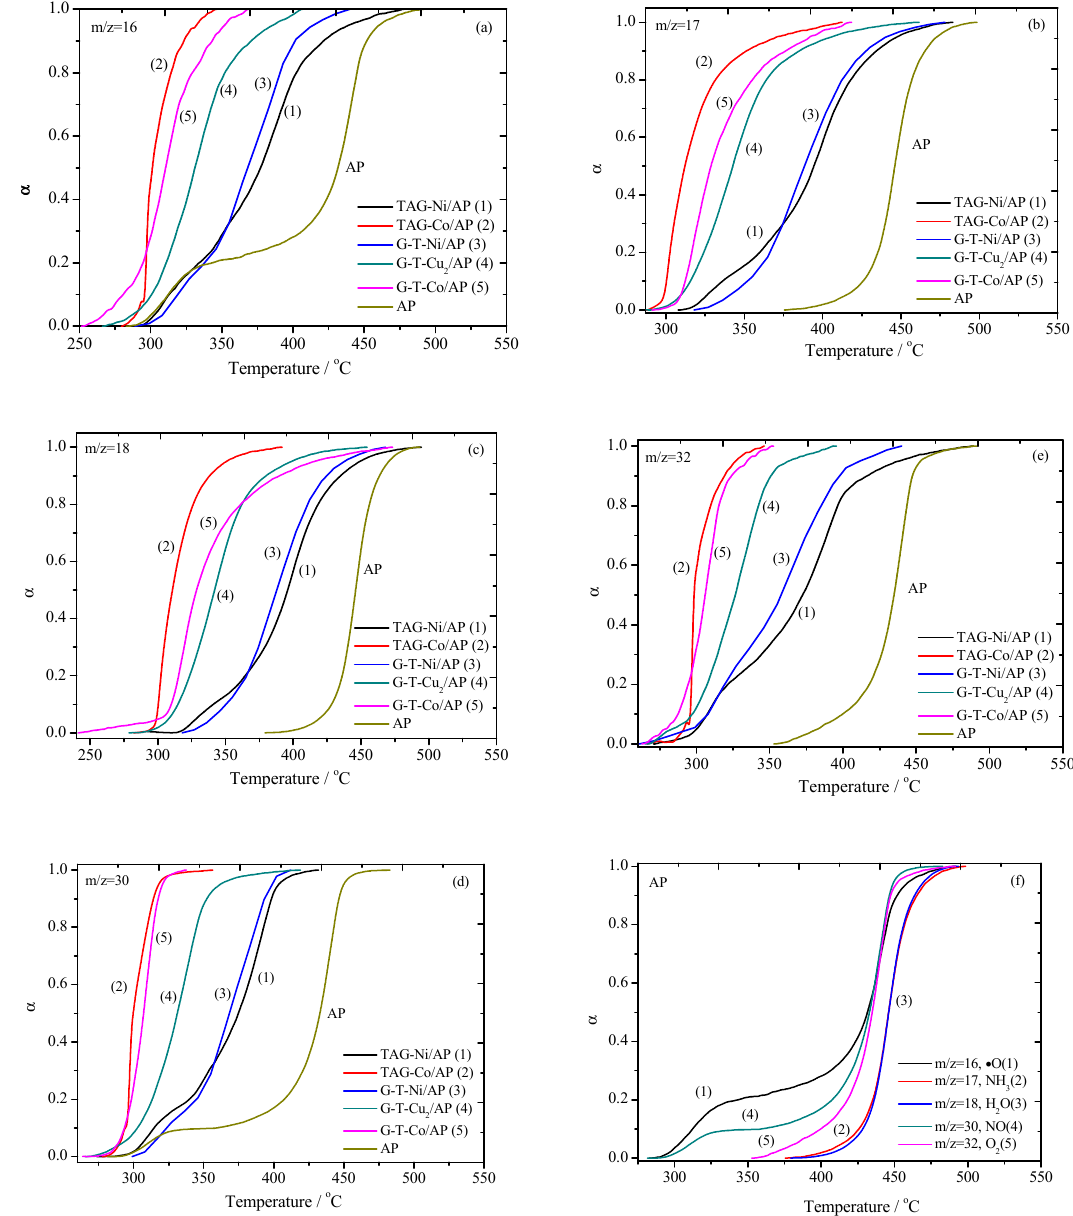
Figure 2. The dependence of accumulation ( α is conversion rate) of the typical gaseous products on the temperature for AP-based mixtures: ( a ) m / z = 16, · O; ( b ) m / z = 17, NH 3 ; ( c ) m / z = 18, H 2 O; ( d ) m / z = O 2 ; ( e ) m / z = 30, NO; ( f ) summary of products evolution processes of pristine AP.